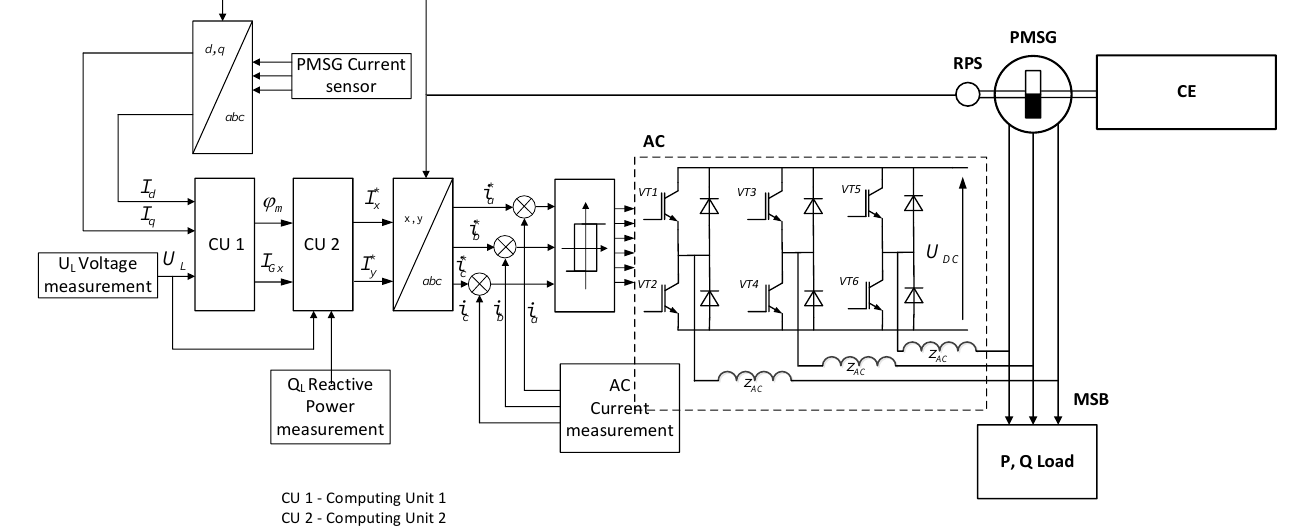
Figure 11. Autonomous hybrid ship power plant system with the PMSG in parallel topology with the control system.